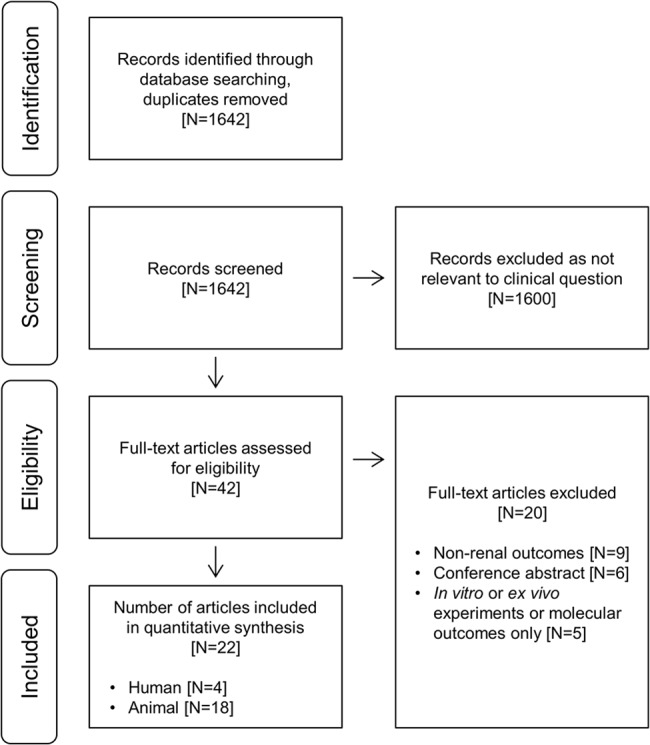
PRISMA (Preferred Reporting Items for Systematic Reviews and Meta-Analyses) flow diagram of the systematic literature search.